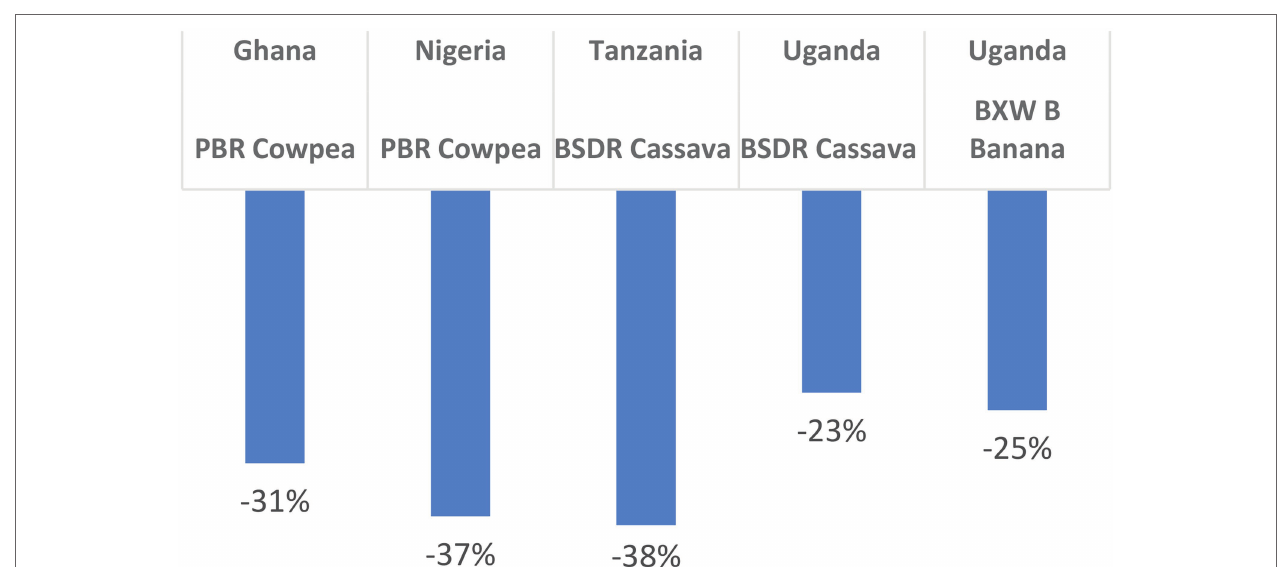
FIGURE 4 | Economic losses due to a 5-year delay* during the R&D/regulatory stages (Dzanku et al., 2018; Phillip et al., 2019; Kikulwe et al., 2020; Ruhinduka et al., 2020). *Impacts of the cost of regulatory delays are estimated maintaining constant the number of years for the simulation after shocking the cash flows with a 5-year